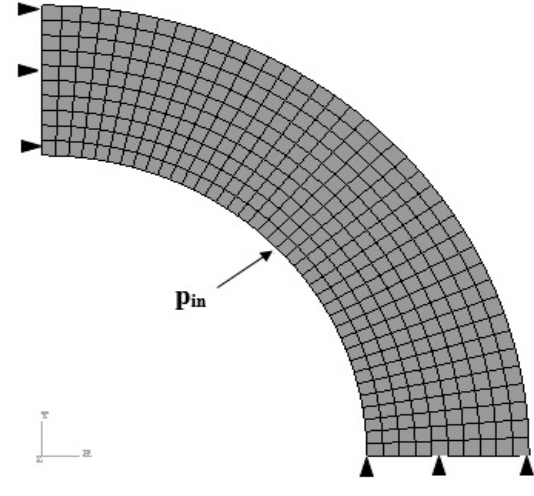
Figure 8. The applied mesh in FE modeling.